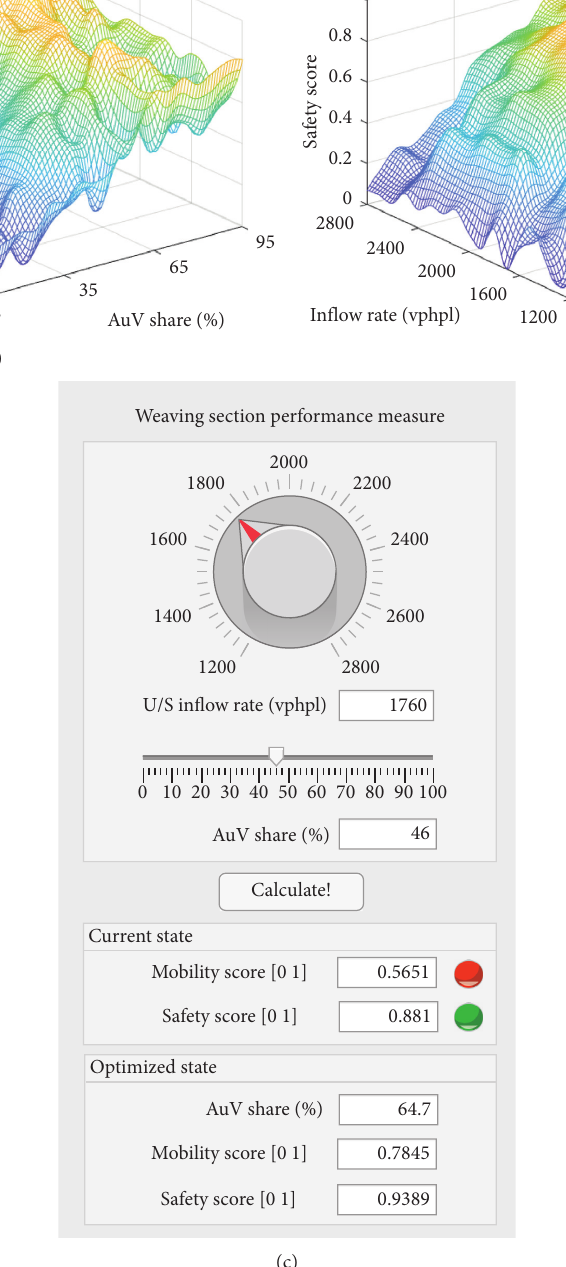
Figure 8: (a) Mobility scores, (b) safety scores for varying inflow rates and mixed traffic scenarios, and (c) user interface of the developed application to assist decision-making for weaving section